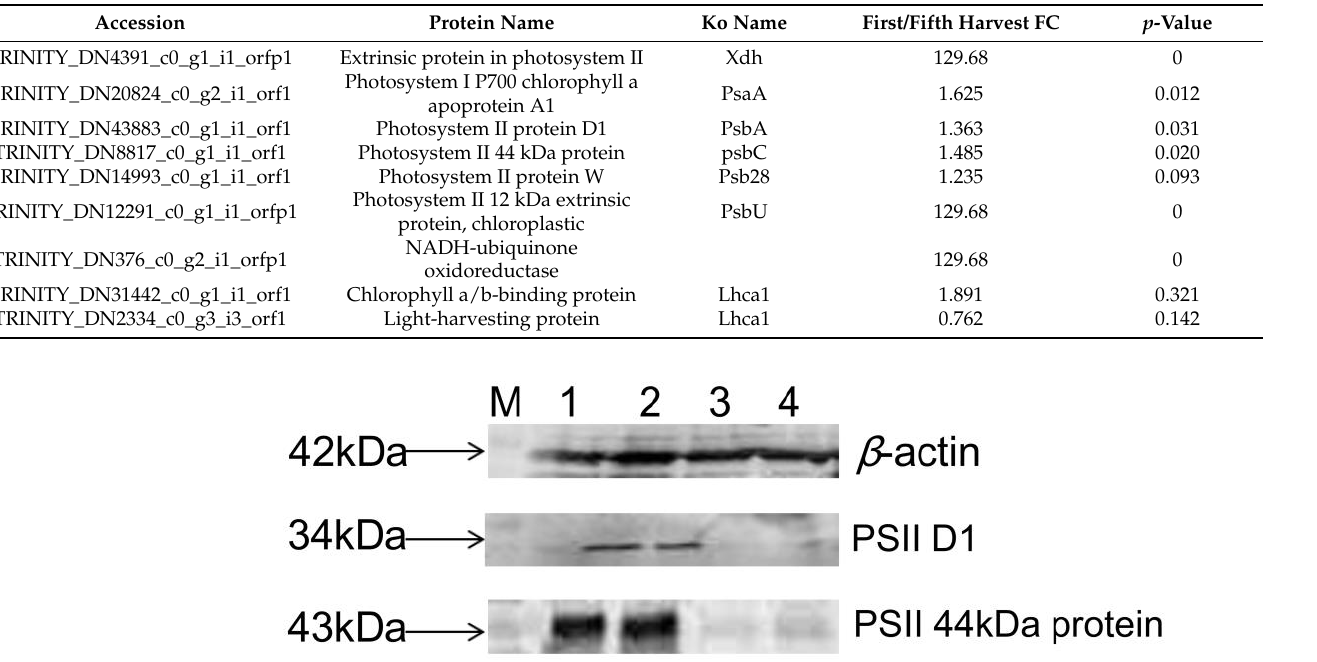
Figure 5. Differential proteins D1 and 44k Da verification result of western blotting (M: Marker 1~2: Fifth, 3~4: First).